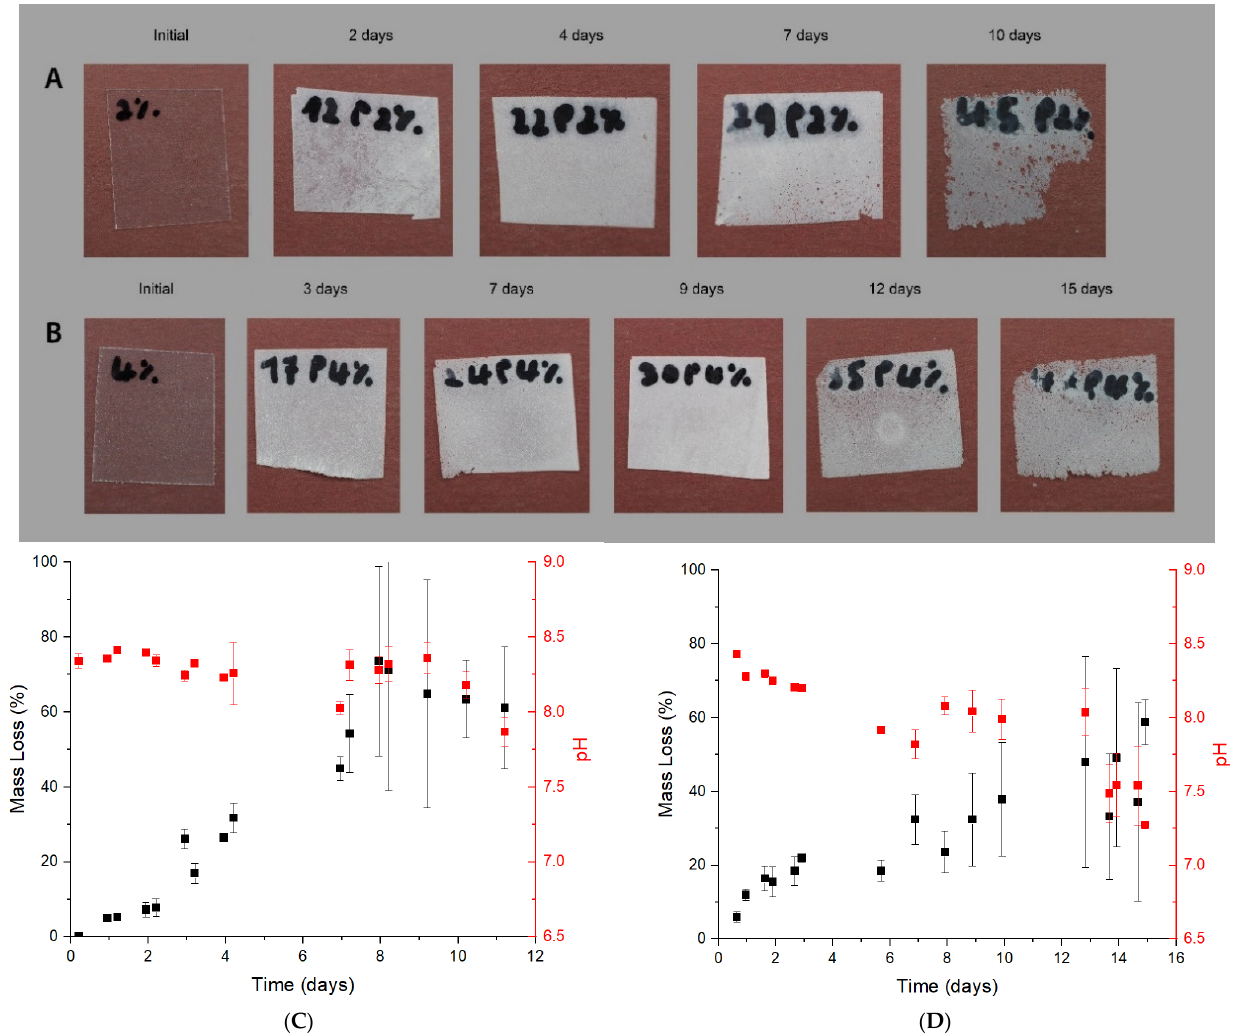
Figure 6. Optical analysis and gravimetrical test of nanocomposites reinforced with a 2% ( A , C ) and 4% ( B , D ) of nanoclays.